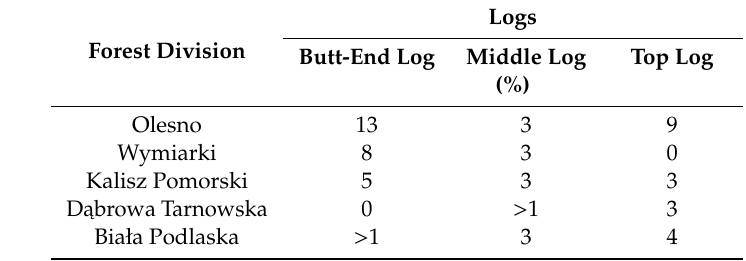
Table 9. The percentage of bark pocket and resin pitch as a factor a ff ecting the quality class of sawn timber in the longitudinal section of long logs for the various forest divisions.